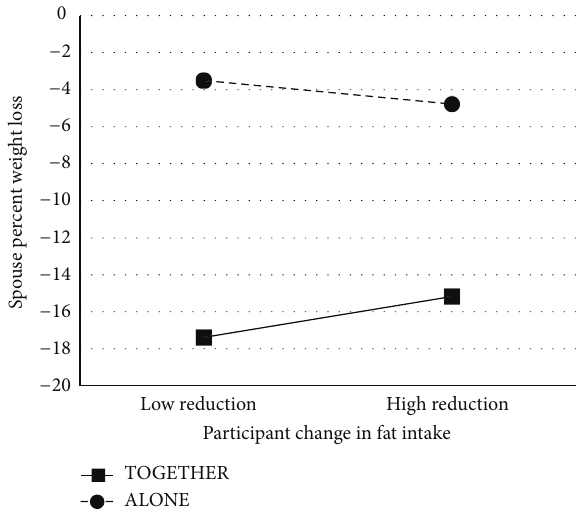
Figure 3: Interaction between treatment group and participants’ fat intake change when predicting spousal weight loss. High and low fat intake reduction are defined as ± 1 SD from the mean reduction score of 5.82% kcal. “High reduction” thus corresponds to a reduction of 15.14% kcal, and “low reduction” corresponds to a gain of 3.50% kcal.